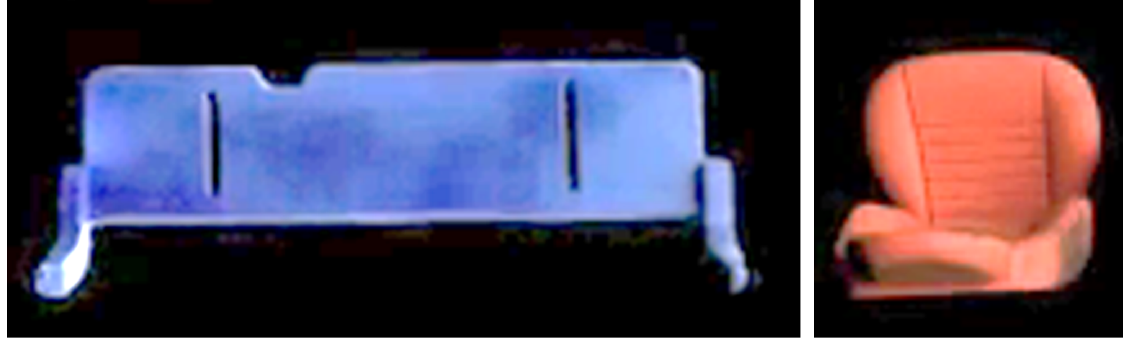
Figure 11. Typical data samples were sampled from demonstration